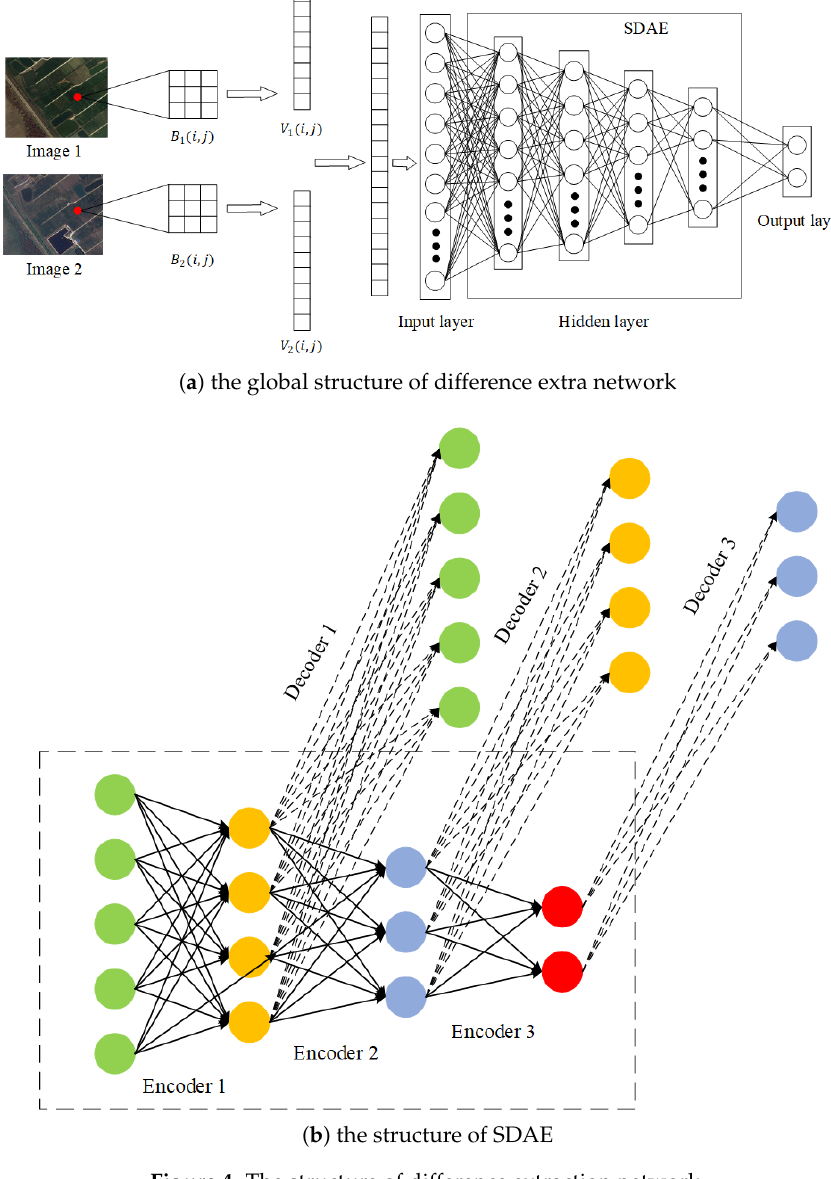
Figure 4. The structure of difference extraction